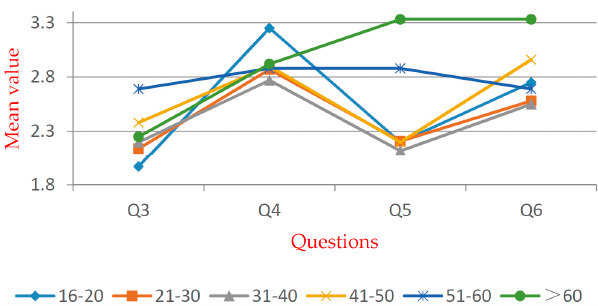
Figure 8. Mean values of “education” group. Figure 9. Mean values of “income” group. Figure 10. Mean values of “distance” group. Figure 5 shows significant differences in all groups. There are significant differences between urban residents and rural residents in Q3–Q6, but the urban residents’ mean value is less than the rural residents’ mean value. This indicates that the awareness level of urban residents in regard to WTE technology, the possible risks, and the related policies is higher than those of rural residents.